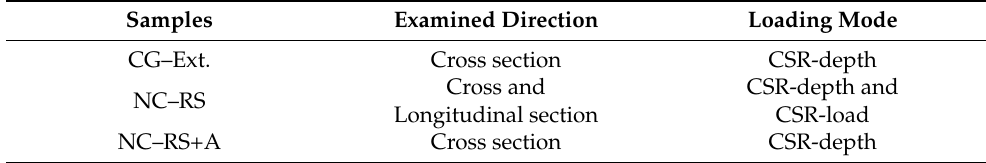
Table 1. Samples examined in this